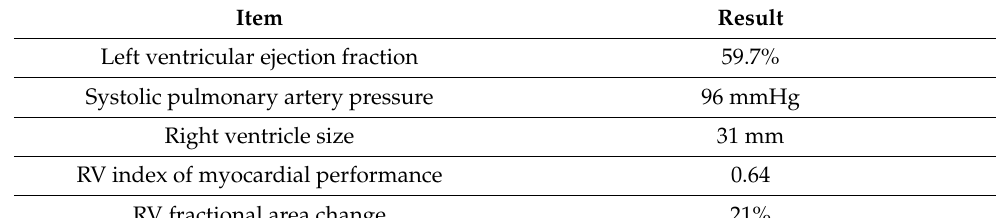
Figure 3. Right Ventricular Index of Myocardial Performance (RIMP) equals (a − b)/b, and the value was 0.64; “a” means tricuspid closure-open time, and “b” means ejection time, respectively. ( A ) The fractional area change of the right ventricle (RV FAC) on the four − chamber view was 21% ( B ).